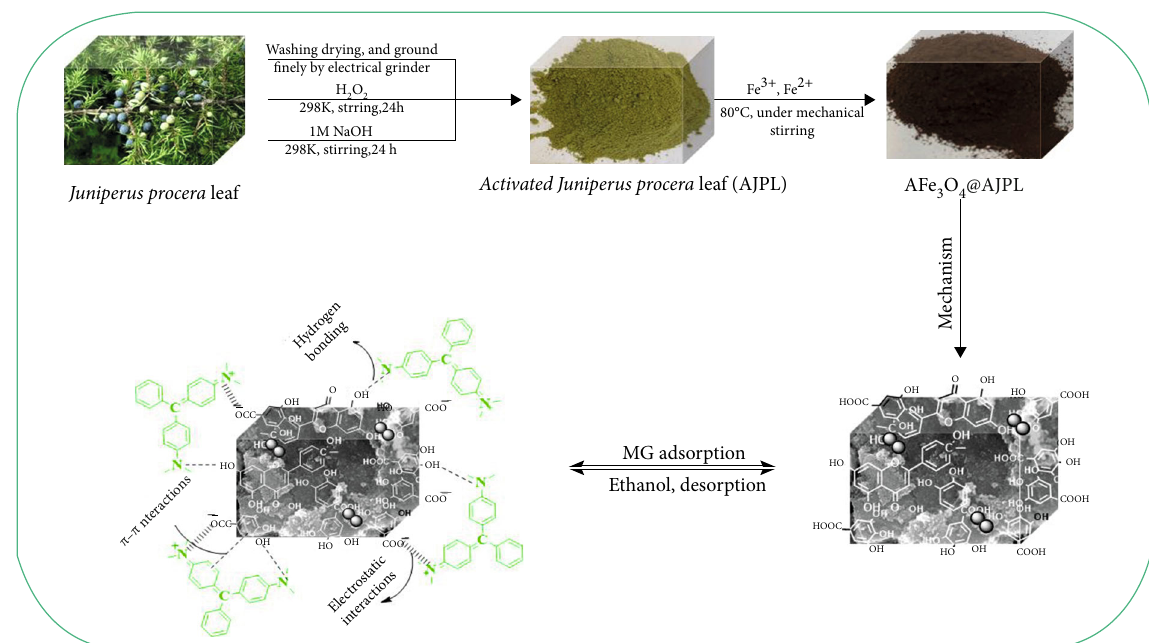
Figure 1: Synthesis of Fe